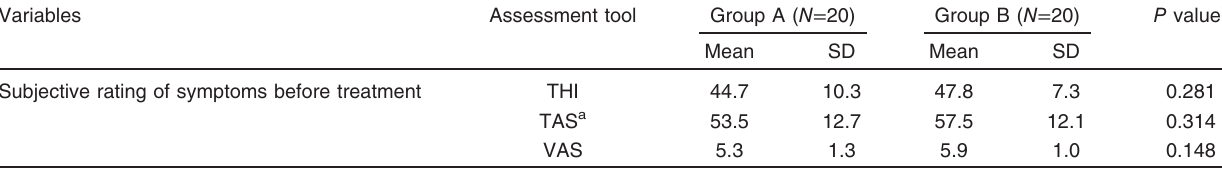
Table 2 Subjective rating of symptoms before treatment in either study group Variables